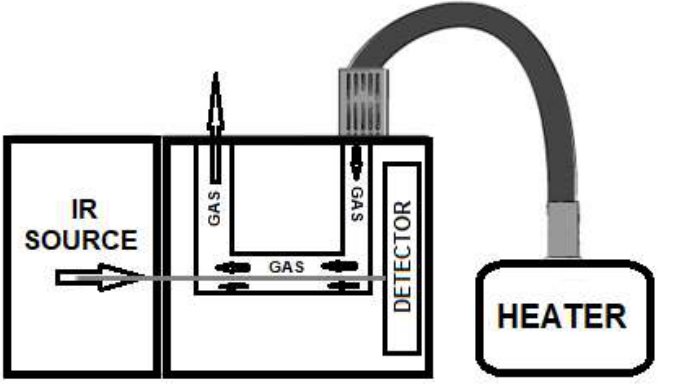
Figure 1. Schematic example of an EGA-FTIR system.